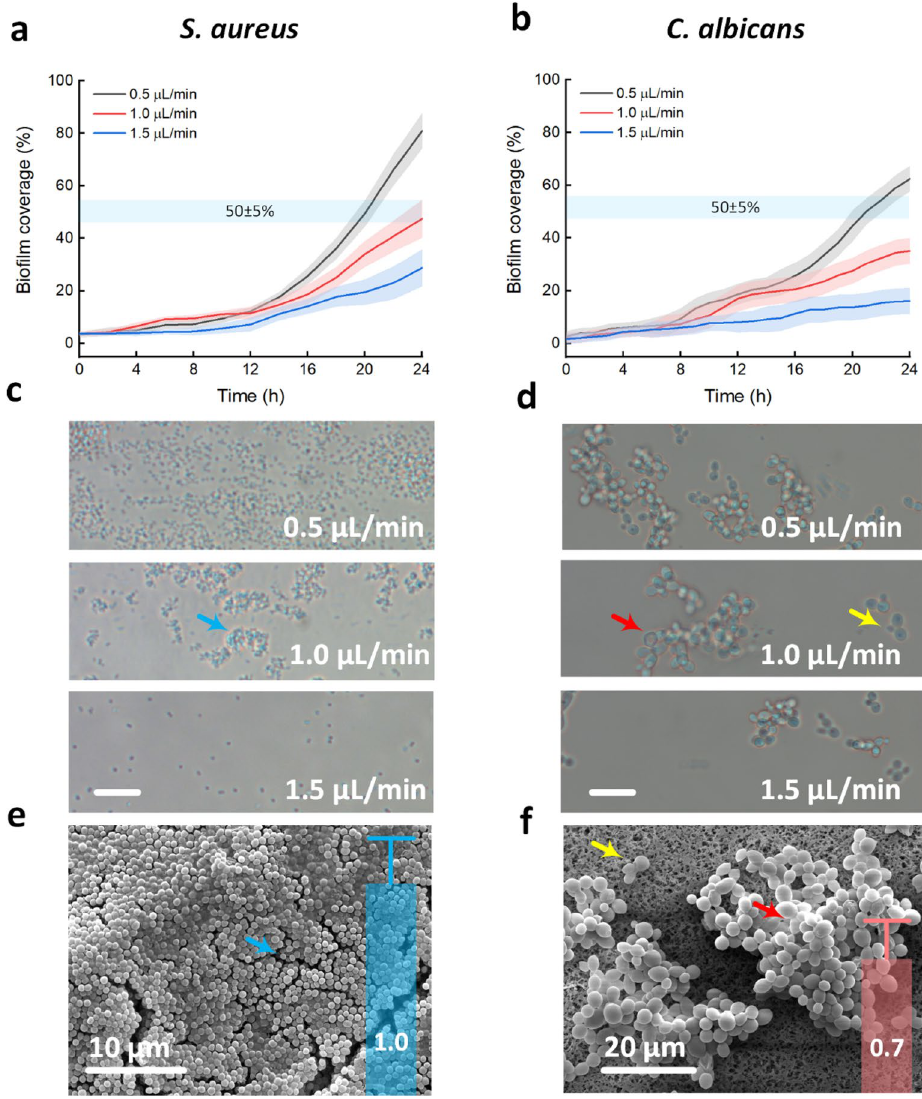
Figure 3. Comparison of biofilm coverages of mono-species biofilm formation under various flow rates (0.5, 1.0, and 1.5 µL/min) in microfluidic channels with static conditions grown on well plates after 24 h of culture. ( a , c ) S. aureus biofilm under hydrodynamic conditions. ( b , d ) C. albicans biofilm under hydrodynamic conditions. ( e , f ) Single-species biofilms ( S. aureus vs. C. albicans ) under static conditions (blue arrows = extracellular matrix; red arrows = pseudohyphae groups; yellow arrows = budding formation). The cyan lines represent the predetermined biofilm coverage (~ 50%) in the FOV on microchannels. Blue and red bar graphs in ( e , f ) show S. aureus and C. albicans biofilm growths in vitro on 96-well plates, respectively, measured by the optical density at 570